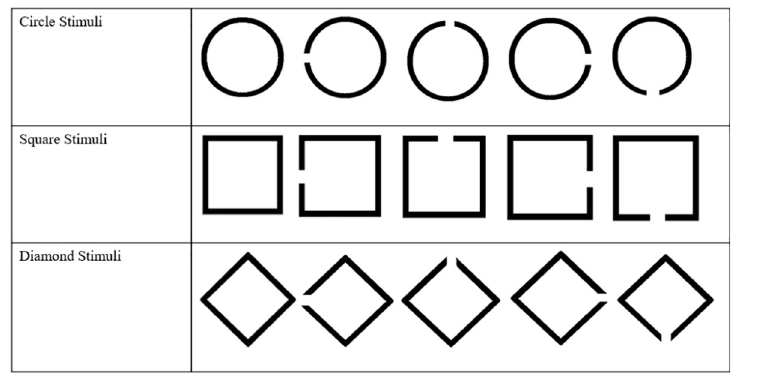
Fig 1. The shape stimuli presented in the Attentional Bias Alignment Assessment